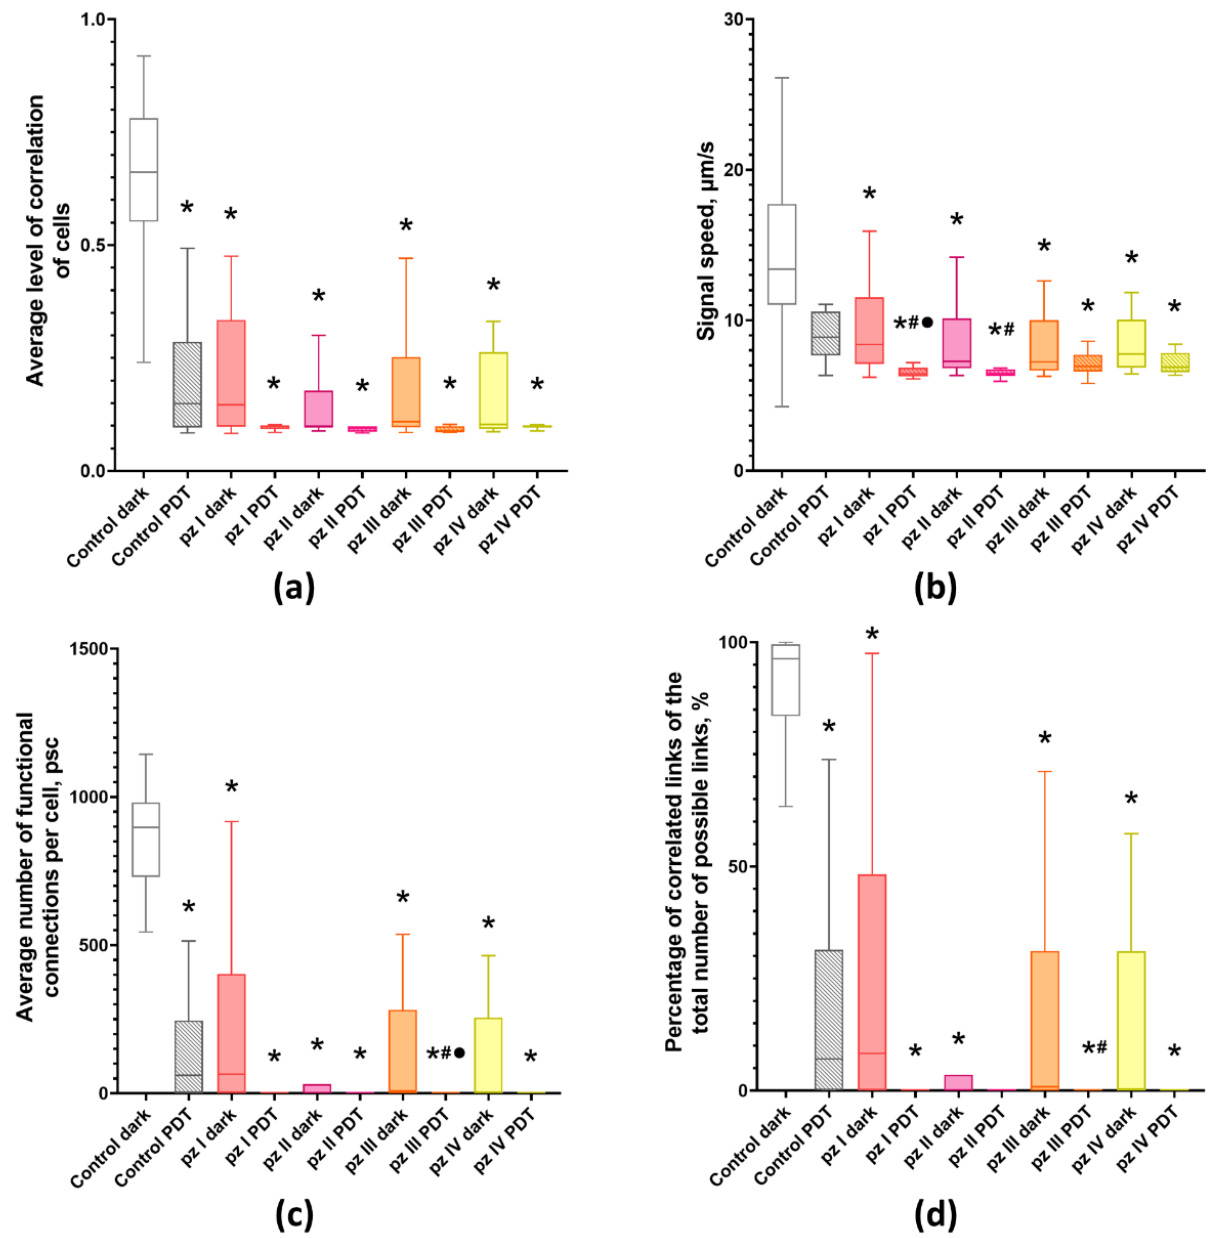
Figure 3. Main parameters of neuron-glial network activity in primary hippocampal cultures the next day after PDT. ( a ) Mean correlation level of cells, ( b ) signal speed, ( c ) average number of functional connections per cell, and ( d ) percentage of correlated connections from the total number of possible connections. * versus “Control dark”, # versus “Control PDT”, ● versus the same pz dark group, p < 0.05, Kruskal – Wallis test.